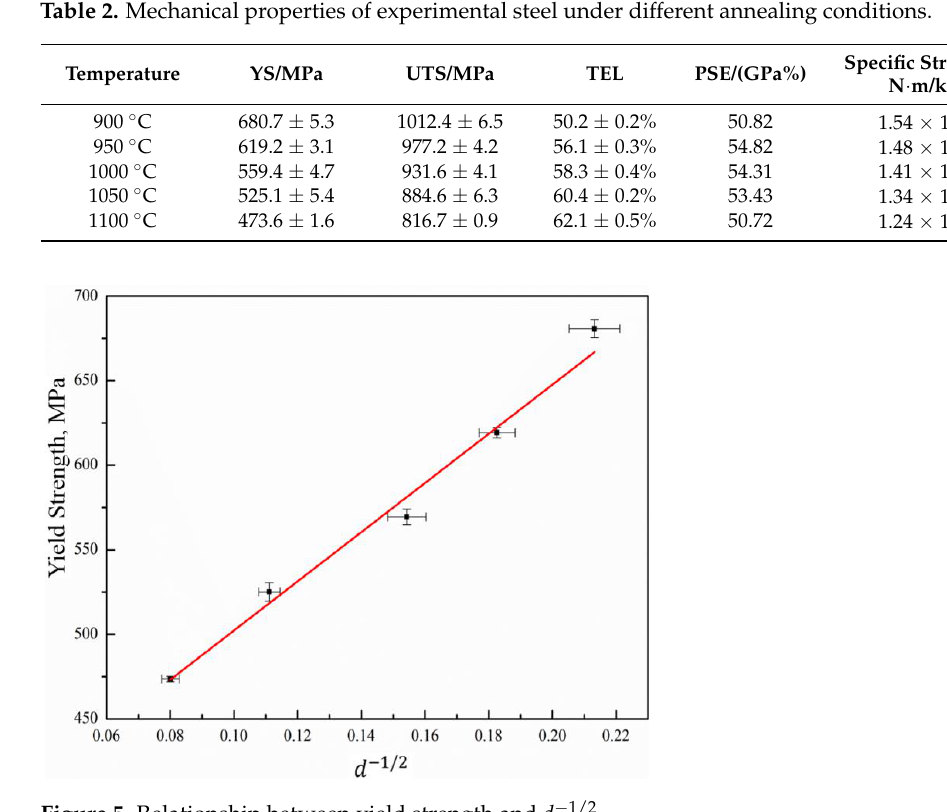
Figure 5. Relationship between yield strength and d −1/2.